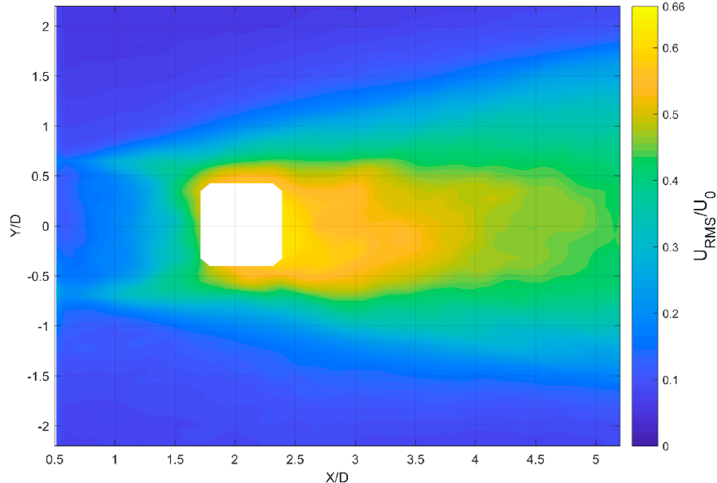
Figure 4. Velocity RMS distribution for full dataset.